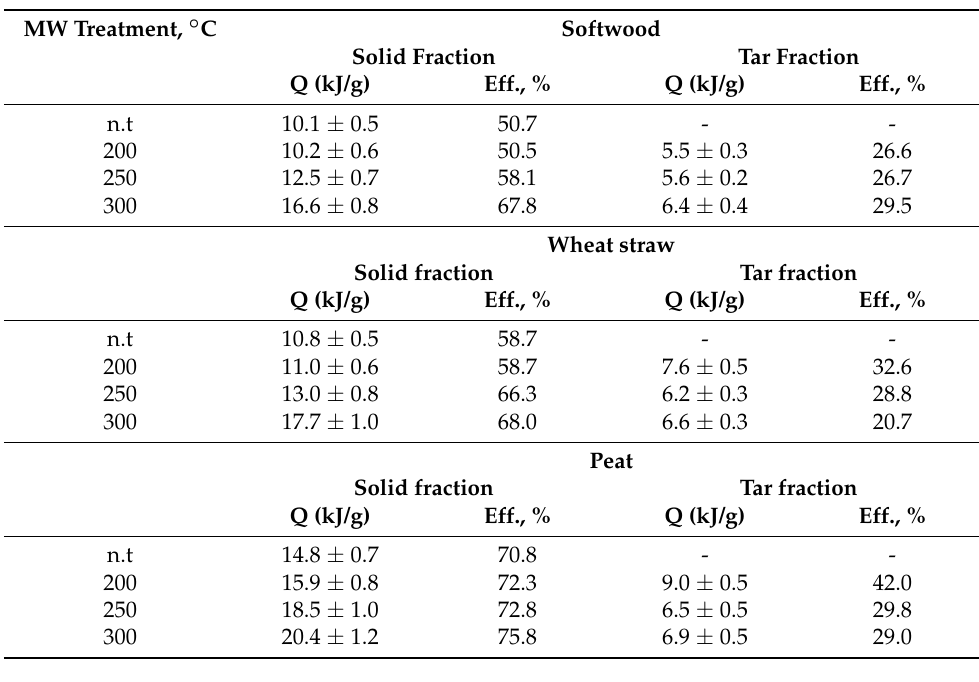
Table 3. Heat output (Q) and the calculated efficiency (Eff.) coefficients according to the DSC tests in air media of the solid and tar fractions that were obtained by MW-assisted torrefaction of biomass at different